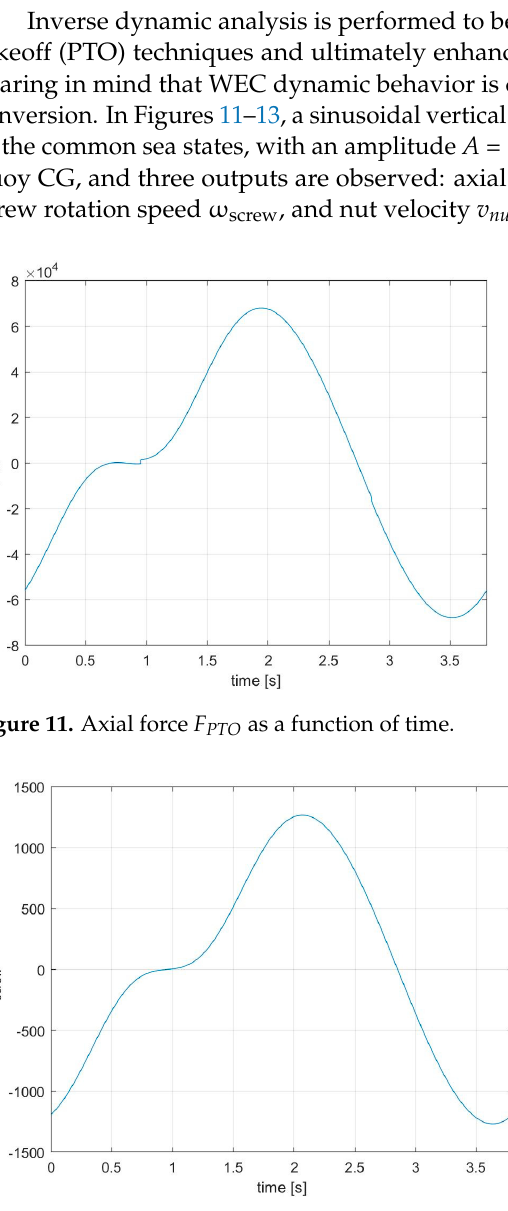
Figure 12. Screw rotation speed ω screw as a function of time.